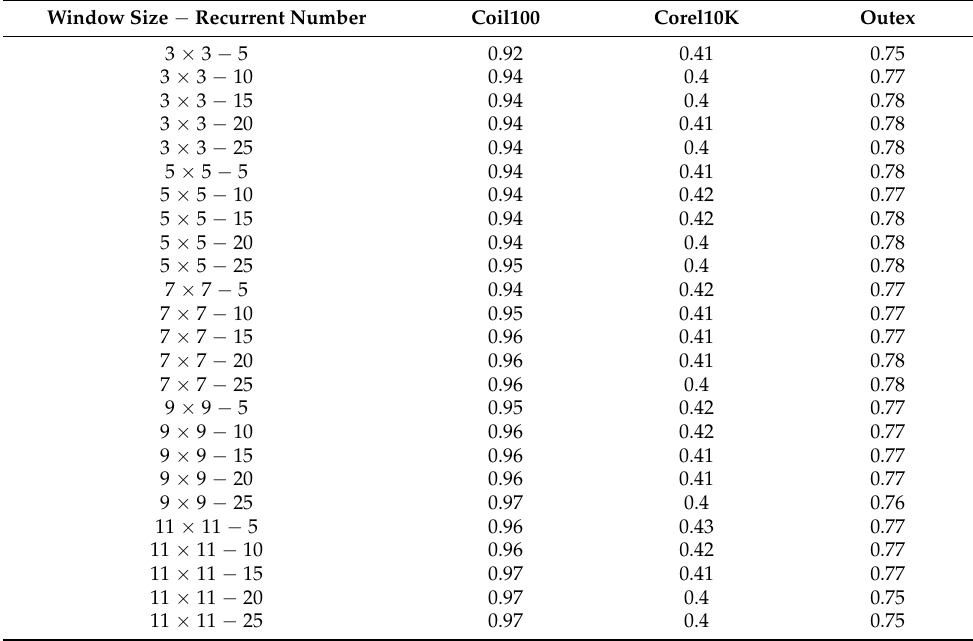
Table 2. Accuracy outputs for various window sizes and transformations for the three datasets using SVM.